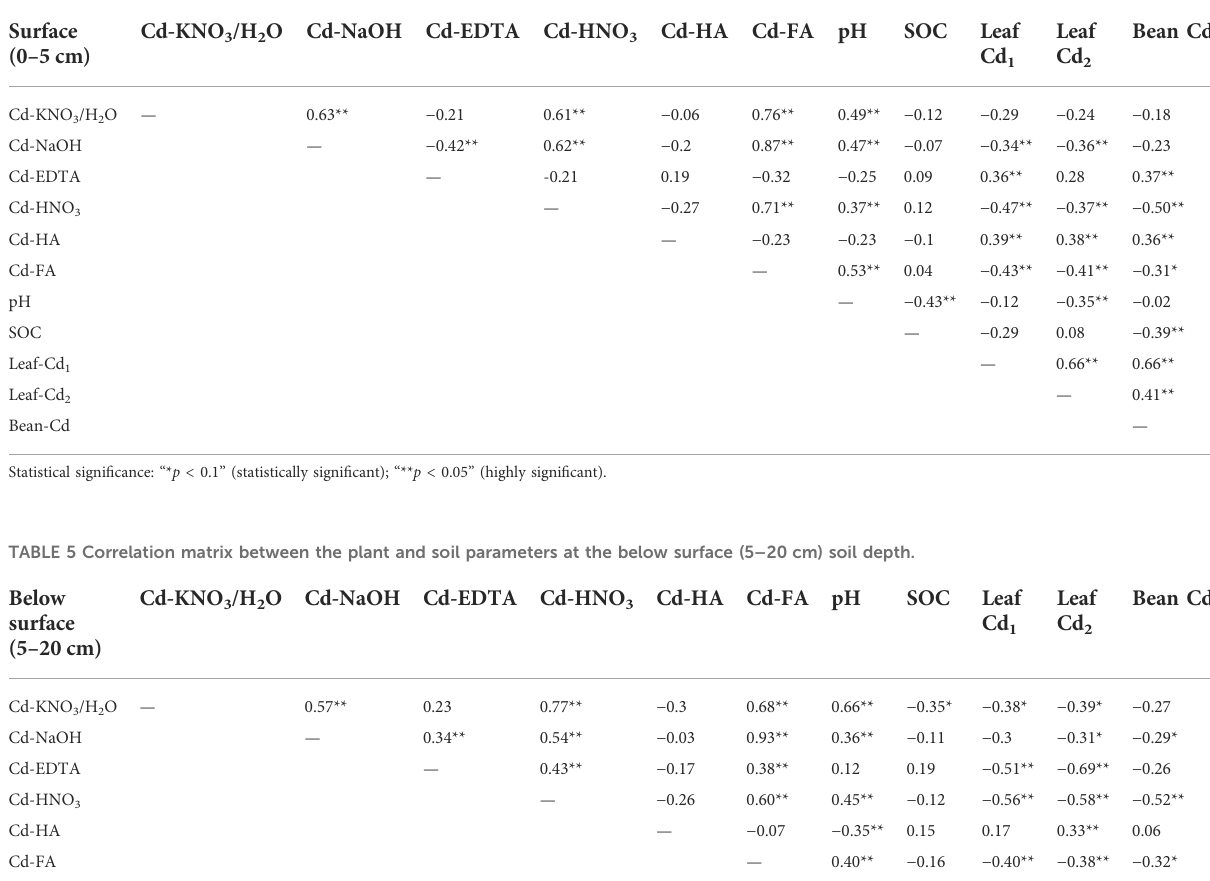
TABLE 4 Correlation matrix between plant and soil parameters at the surface (0 – 5 cm) soil depth.